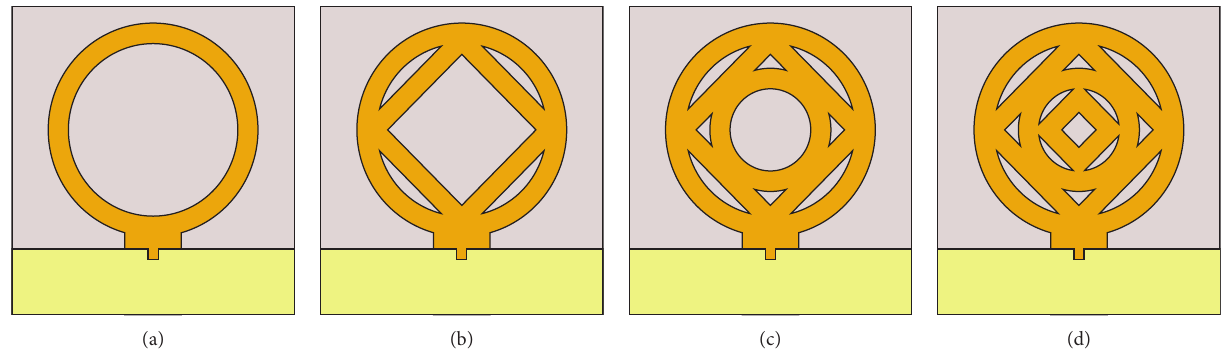
Figure 2: Design evolution of the proposed fractal antenna: (a) iteration-1; (b) iteration-2; (c) iteration-3; (d) iteration-4 (proposed design).